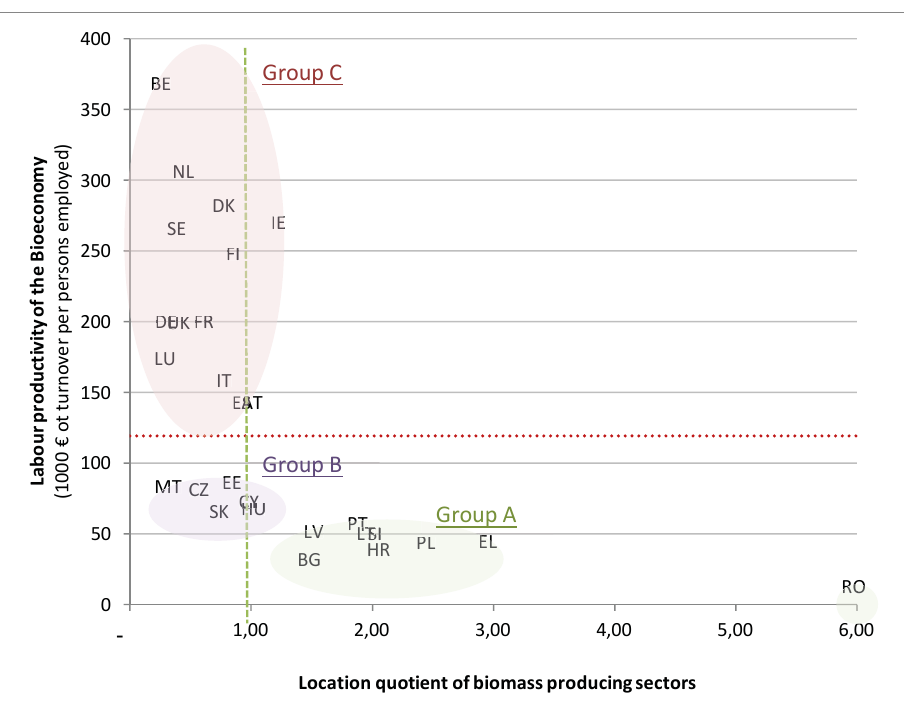
Figure 3 . The three main bioeconomy patterns in EU Member